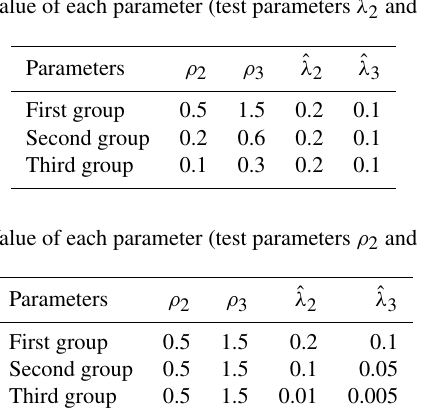
Table 2. Value of each parameter (test parameters ˆ λ 2 and ˆ λ 3 ).